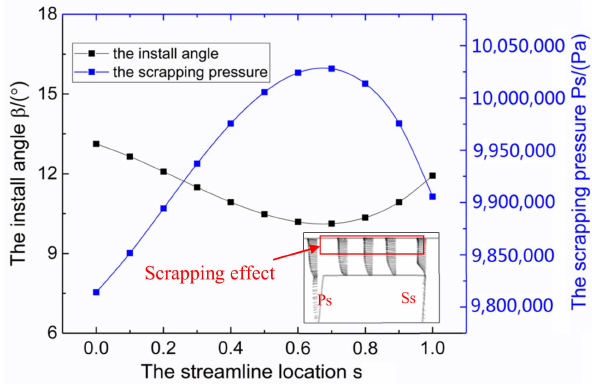
Figure 16. Distribution of the extracted scraping